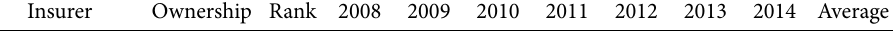
Allianz General Insurance